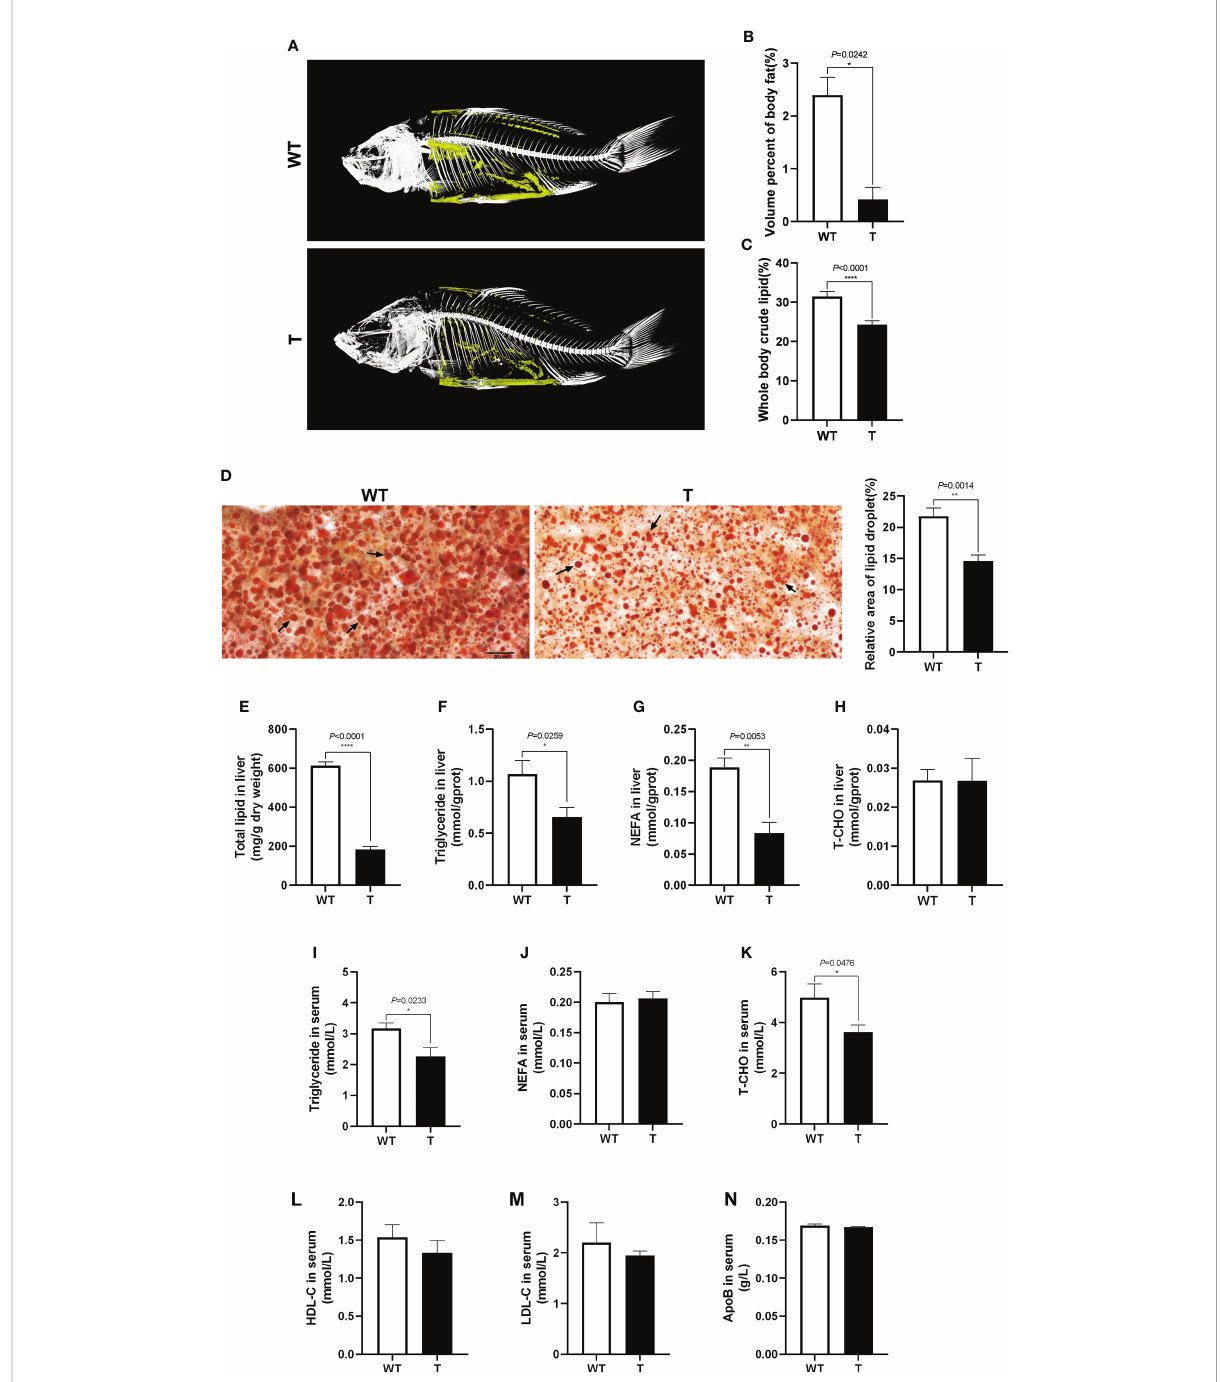
FIGURE 2 Effects of GH overexpression on lipid accumulation in common carp. (A) Mirco-CT of wild-type (WT) and GH transgenic (T) common carp (n = 3). The body fat in the fi sh was colored yellow. (B) The statistical graph of body fat by micro-CT of WT and T common carp (n = 3). (C) Whole body crude lipid of WT and T common carp (n = 3). (D) The liver slices were stained with Oil Red O. Scale bars, 25 m m (40×) (n = 6), the lipid droplet was indicated by arrows, the column graphs in the right of pictures represent the relative lipid droplet area of liver tissue. (E – H) Total lipid, triglyceride, NEFA, and T-CHO content in liver of WT and T common carp (n = 6). (I – K) Triglyceride, NEFA, and total cholesterol (T-CHO) content in serum of WT and T common carp (n = 6). (L – N) High-density lipoprotein cholesterol (HDL-C), low-density lipoprotein cholesterol (LDL-C), and apolipoprotein B (ApoB) content in serum of WT and T common carp (n = 6). *, **, and **** indicate 0.01 < P < 0.05, 0.001 < P < 0.01, P < 0.0001, respectively, between WT and T common